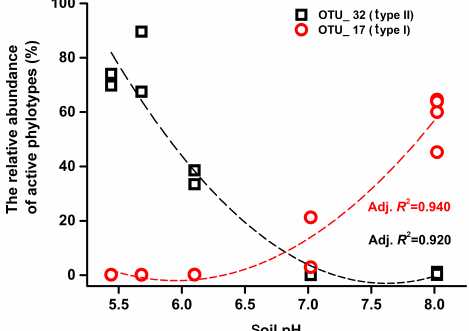
Figure 4. The relationship between soil pH and the relative abun- dance of major 13 C-labeled methanotrophic phylotypes (OTUs). OTU_17 and OTU_32 are the same OTUs displayed in Fig.